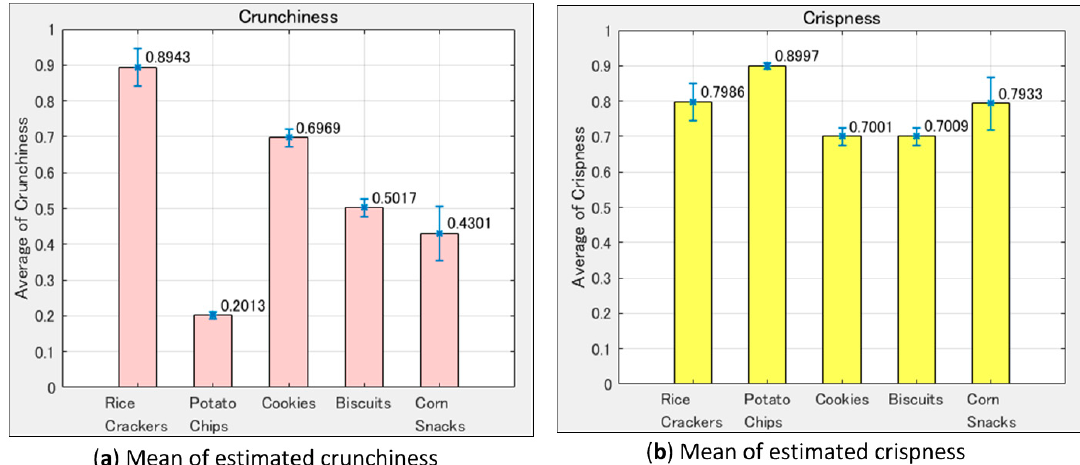
Figure 14. Texture evaluations of the samples using data sets of Figure 13: ( a ) The mean of estimated crunchiness degree and ( b ) crispness degree.